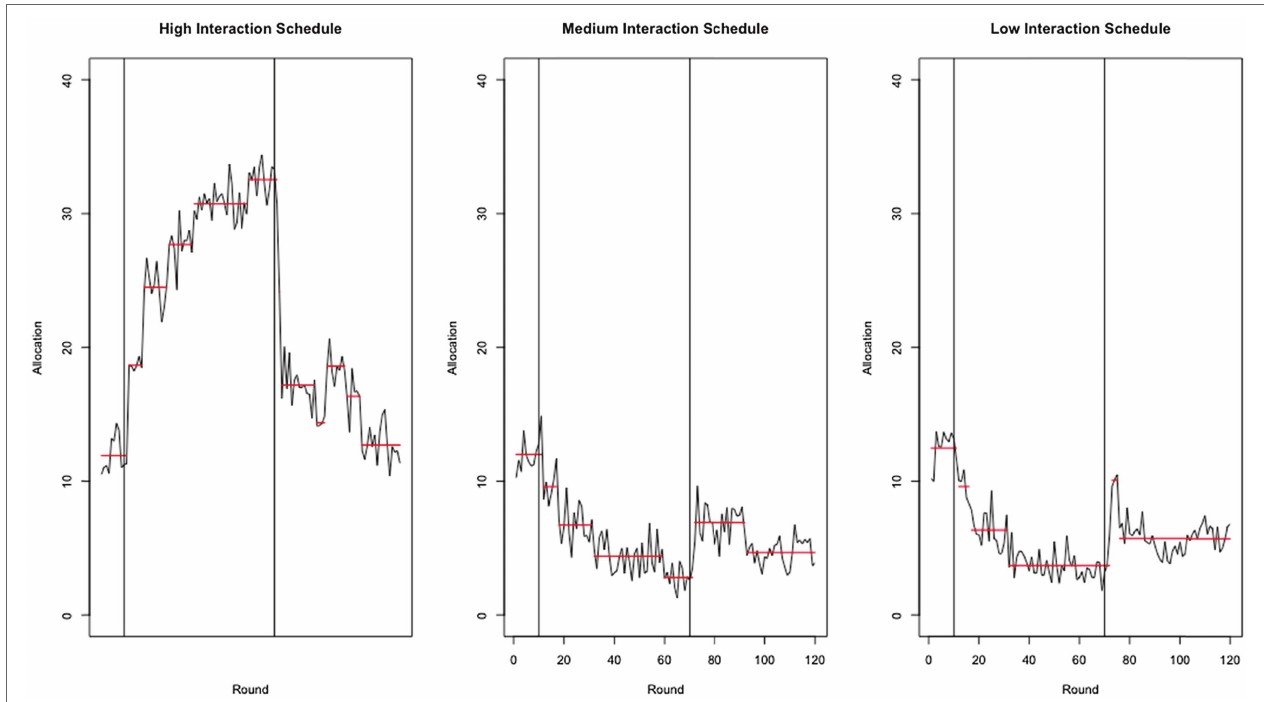
FIGURE 4 | Average amount sent (allocation) by participants by round, interaction schedule, and strategy. The red lines mark the change points detected by the PELT method (Killick et al.,